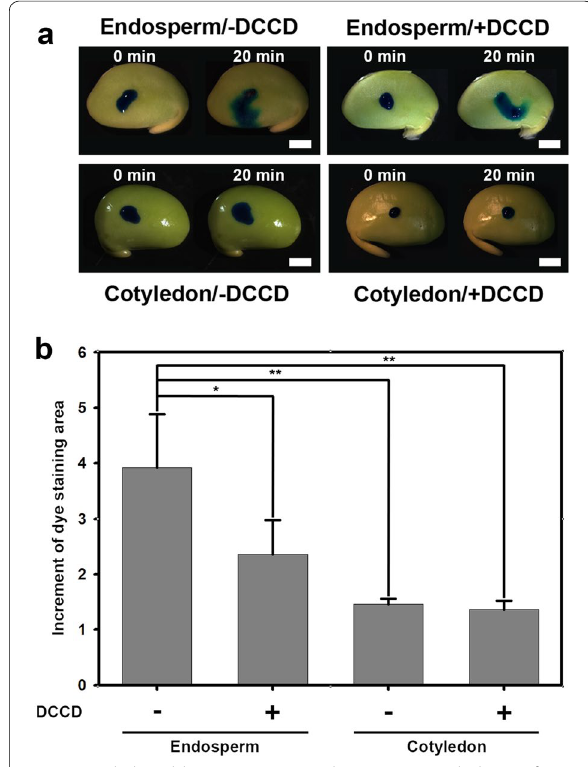
Fig. 3 Methylene blue staining on endosperm or cotyledon surface. a Increment of dye staining‑area at 0 and 20 min after application of methylene blue on soybean endosperm or cotyledon, with or without DCCD treatments. b The dye staining area of endosperm without DCCD treatment was significantly larger than in endosperm with DCCD treatment and cotyledon with or without DCCD treatments. The data were analyzed by ANOVA with Scheffe’s S method (* p < 0.05; ** p < 0.01). Data are mean ±